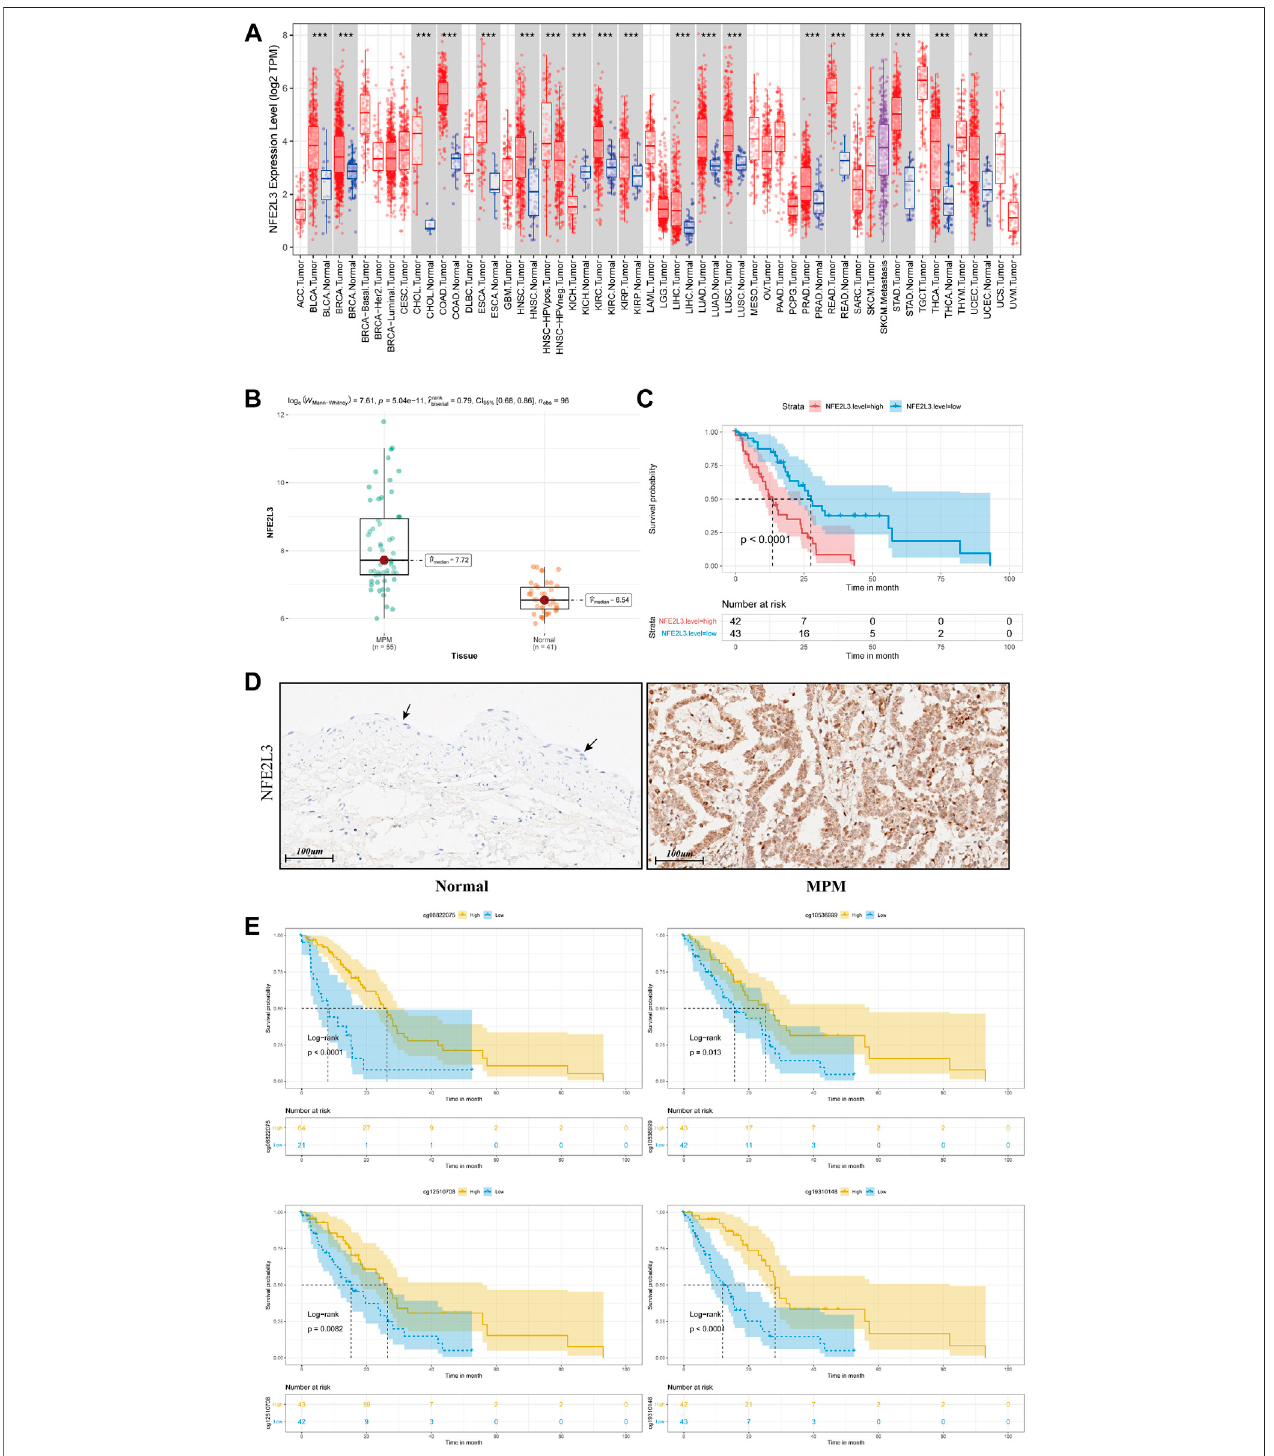
FIGURE5|(A) Pan-canceranalysisofNFE2L3expressionofallsamplesinTCGA. (B) BoxplotofNFE2L3expressionintumortissuesandpairednormaltissuesof samples from GSE51024 (C) Kaplan – Meier curve of patients from TCGA when using the median of NFE2L3 expression as the cut-off value. (D) Immunohistochemical staining of NFE2L3 in normal pleural epithelial tissue (black arrow) and malignant pleural mesothelioma tumor tissue (E) Kaplan – Meier curves depicting the relationships between DNA methylation levels of NFE2L3 related sites and prognosis of patients with MPM.